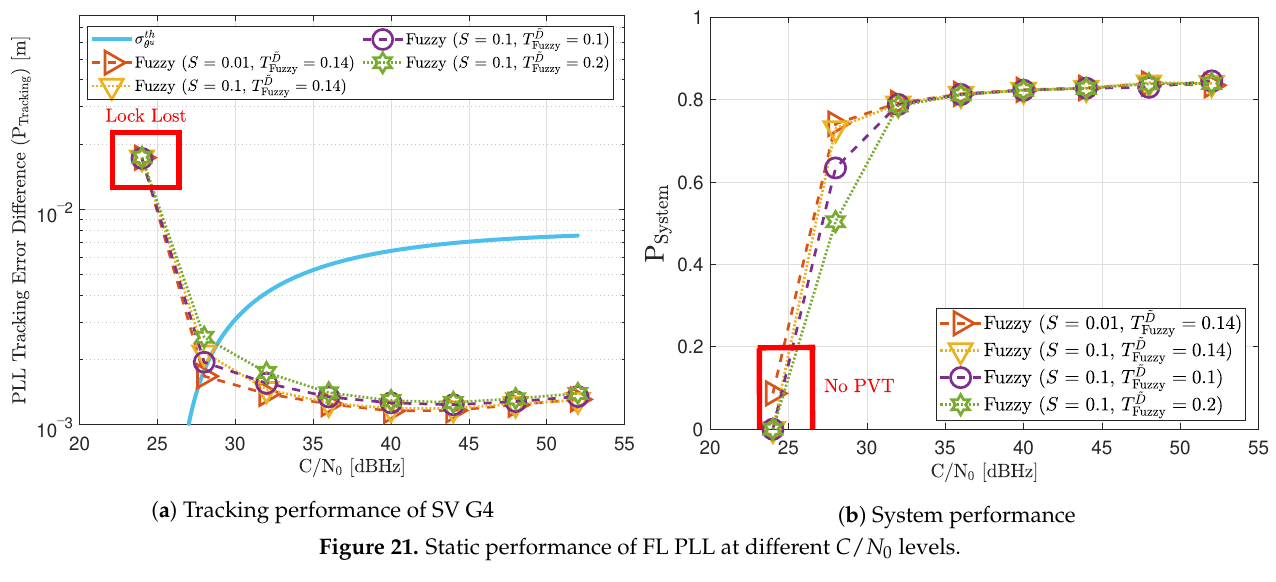
Figure 21. Static performance of FL PLL at different C / N 0